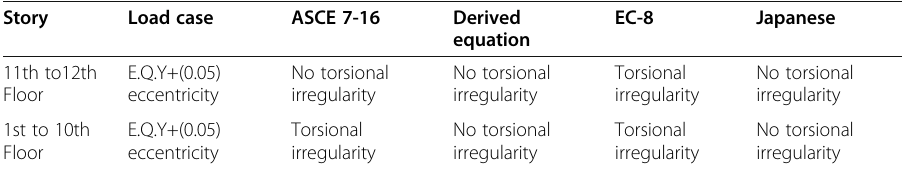
Table 7 Torsional irregularity check of 1st model due to ASCE 7-16, EC-8, Japanese, and derived equation